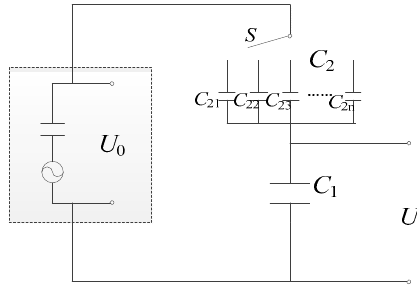
Figure 9. The voltage-reduced capacitive